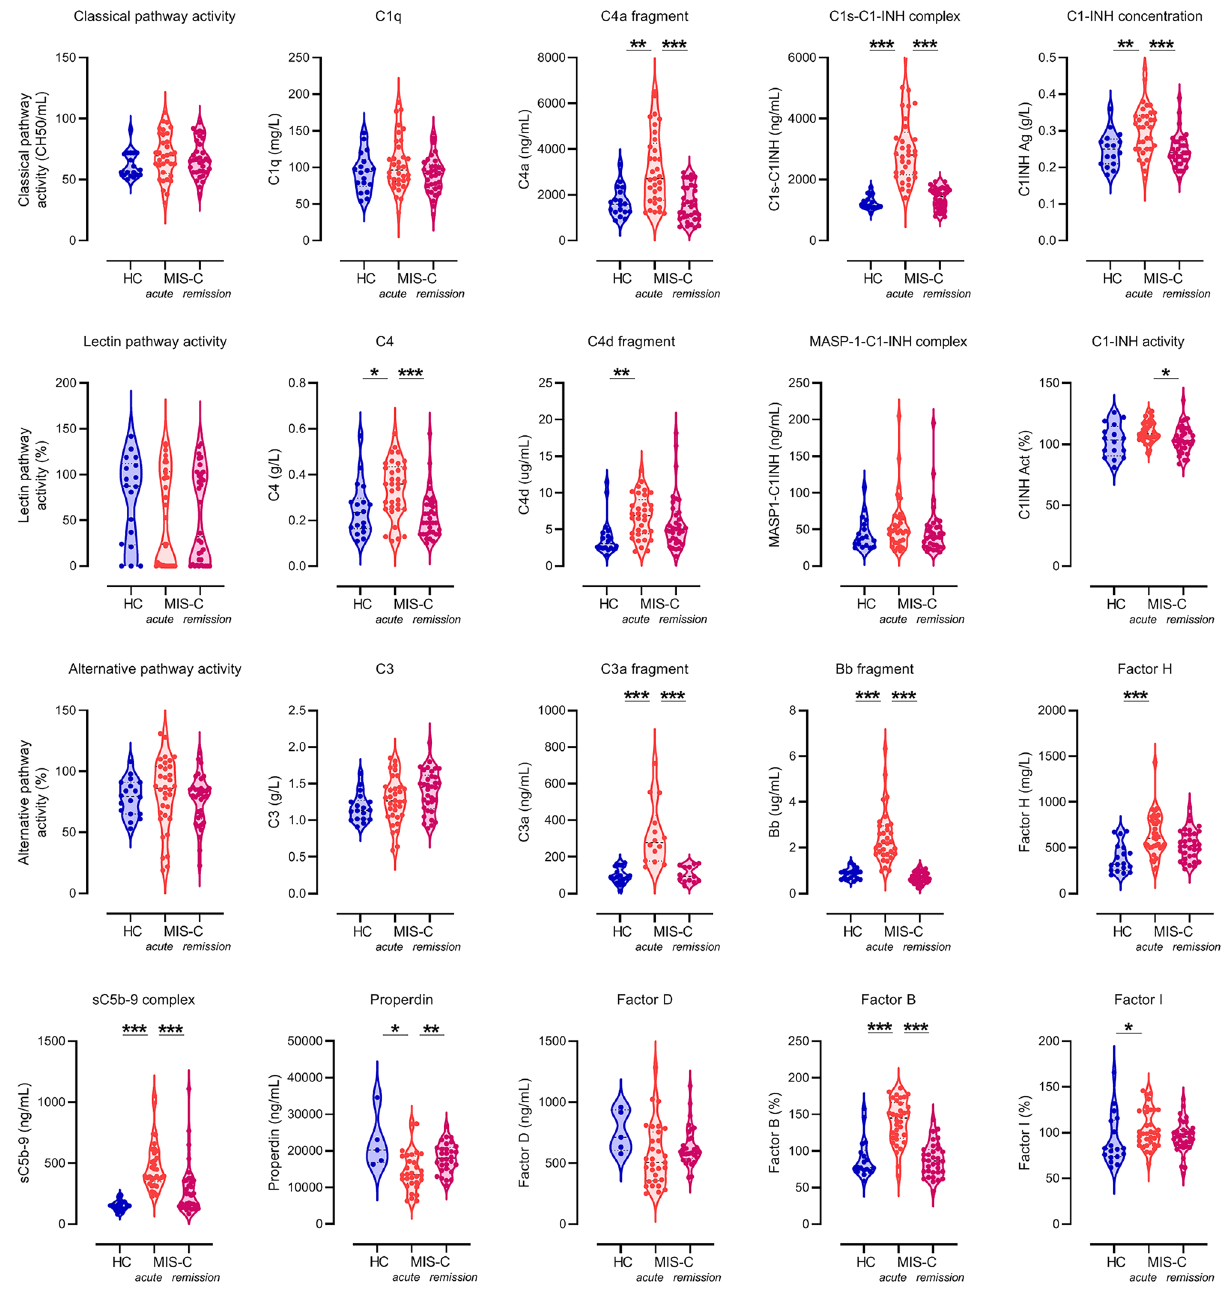
Figure 3. Detailed complement profile of the MIS-C cohort before, during and after IVIG therapy, and of healthy controls. Levels of the complement pathway (classical-, lectin- and alternative) activities, factors (C1q, C4, C3, Factors D, B and properdin) and regulators (C1-inhibitor antigen and activity, Factors H and I) were determined in serum, whereas that of activation products (C1s-C1-inhibitor complex, MASP1-C1-inhibitor complex, C4a, C4d, C3a, Bb and sC5b-9) in EDTA plasma. Violin plots (with dashed horizontal lines indicating the median values, dotted lines indicating the quartiles) show results for the 18 healthy control children (HC), and for all MIS-C cases who had samples from acute stage, before IVIG treatment, or from stable remission after hospital discharge. P values for the pair-wise group comparisons (HC-acute and acute-remission groups) on the violin plots were calculated by the Mann–Whitney test. Non-significant differences are not marked, and p value symbols (* p < 0.05, ** p < 0.01, *** p < 0.001) indicate significant results after 5% false discovery rate correction using the Benjamini–Hochberg